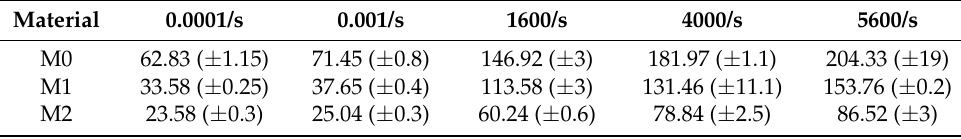
Table 2. Quasi-static and high strain rate compression strength for M0, M1 and M2.